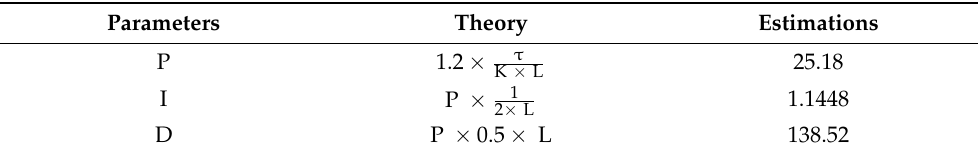
Table 2. Ziegler–Nichols method; theory and estimations.